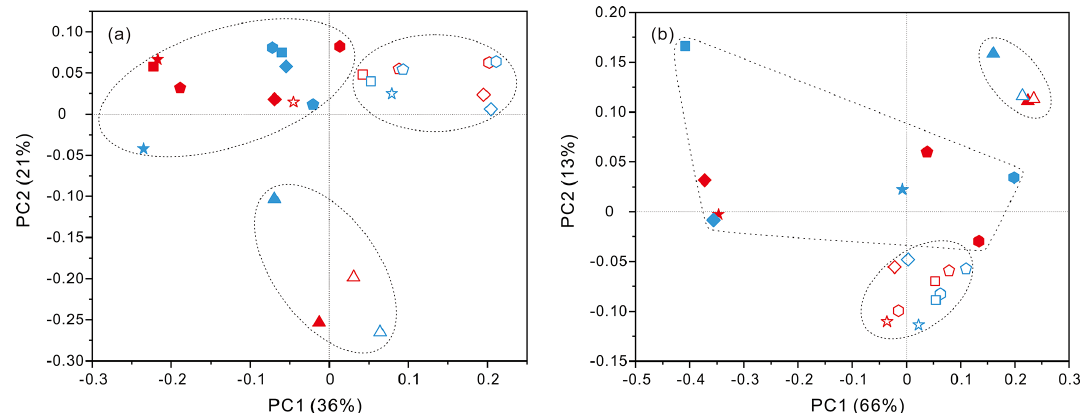
Figure 3. Results of PCoA analysis for particle-attached and free-living microbial fractions collected from seawater columns of the South China Sea. (a) PA and FL bacteria; (b) PA and FL archaea. Statistical analyses supported the groups with statistical significances (Table S3). Triangle: 50m; rhombus: 200m; hexagon: 1000m; star: 2000m; square: 3000m; pentagon: 4000m. Blue color: J5 station; red color: G3 sta- tion. Filled: particle-attached fraction; open: free-living fraction.